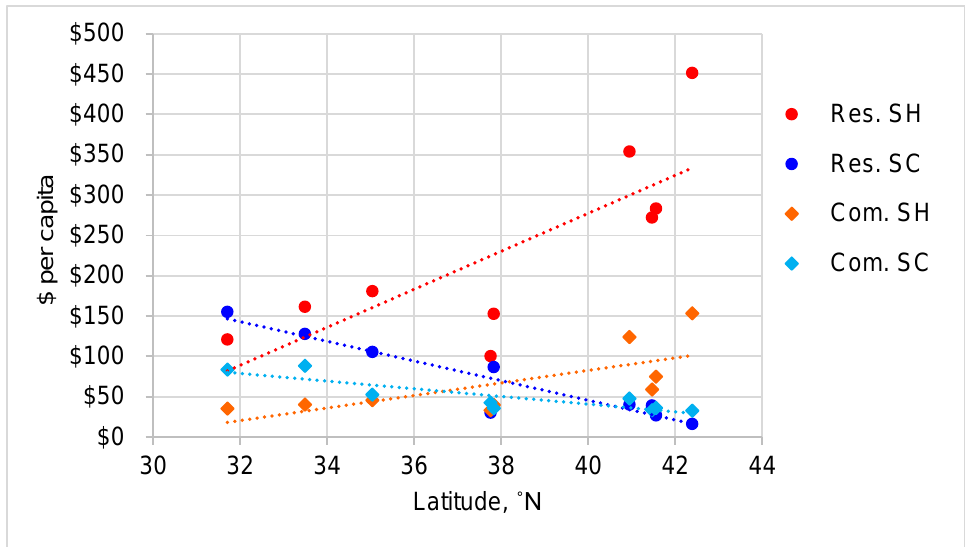
Figure 7. Residential and commercial buildings per capita space heating and space cooling expenditure versus population centroid latitude, for the nine census divisions.